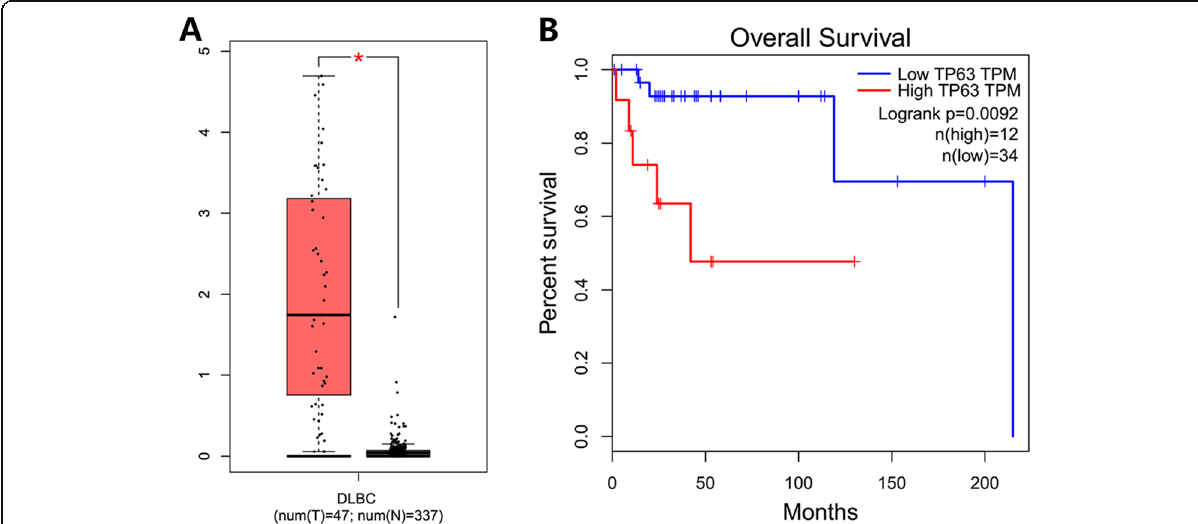
Fig. 5 a The expression intensity of P63 mRNA was significant ( P < 0.001) between DLBCL and normal lymphoid tissues, and b predicted unfavorable prognosis in TCGA DLBCL datasets ( P =